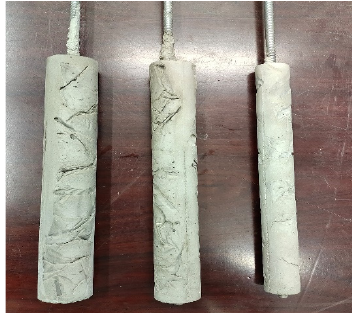
Figure 2. Bolt models.